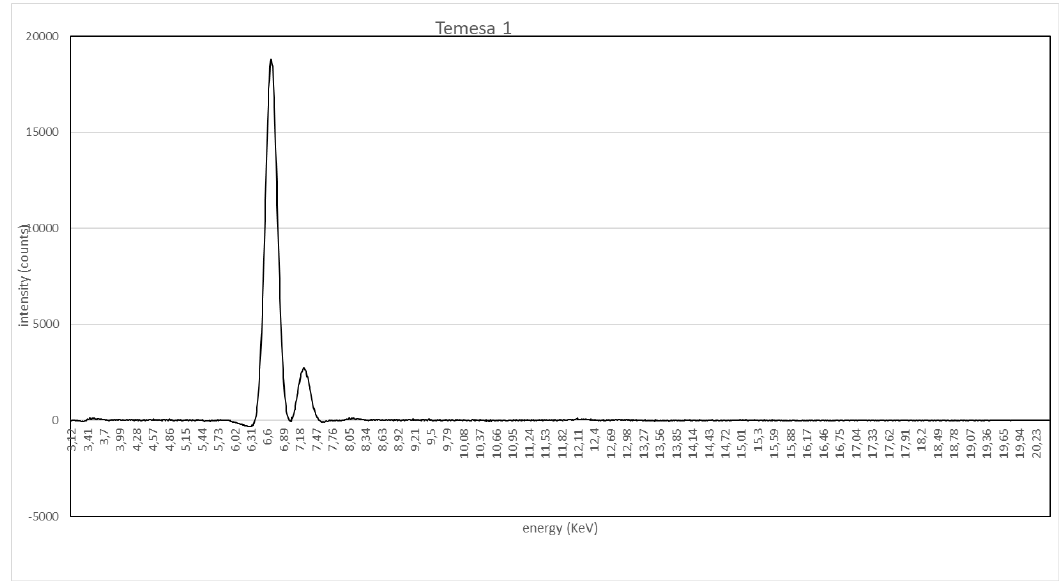
Figure 3. Temesa 1: XRF spectrum.